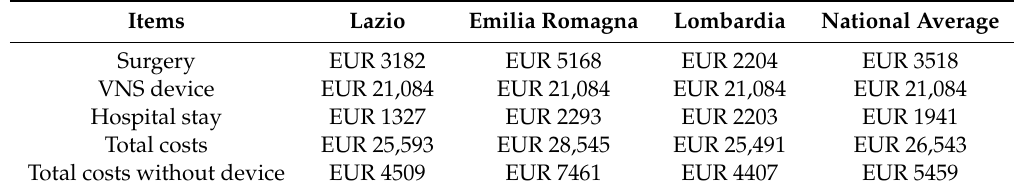
Table 2. Full cost hospital of VNS implantation—region details.